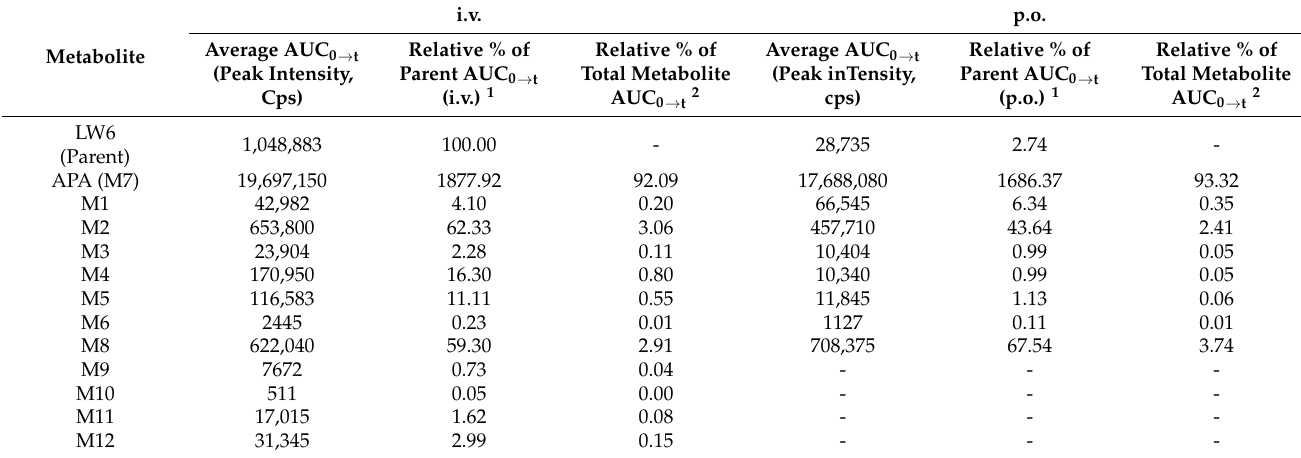
Table 2. Relative percentage of area under the peak area–time curve (AUC) values for LW6 and its metabolites. i.v. Metabolite